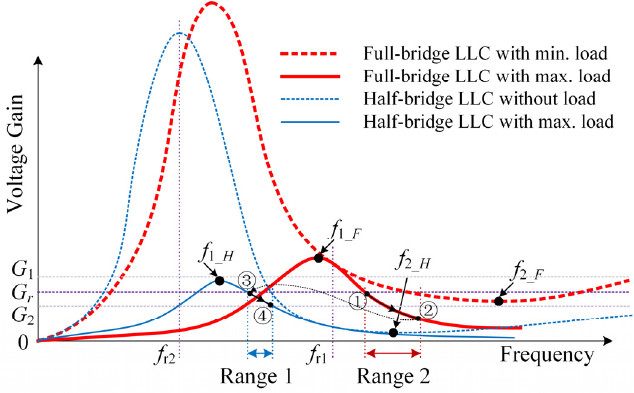
Figure 8. Voltage gain and frequency range selection in full-bridge and half-bridge LLC.